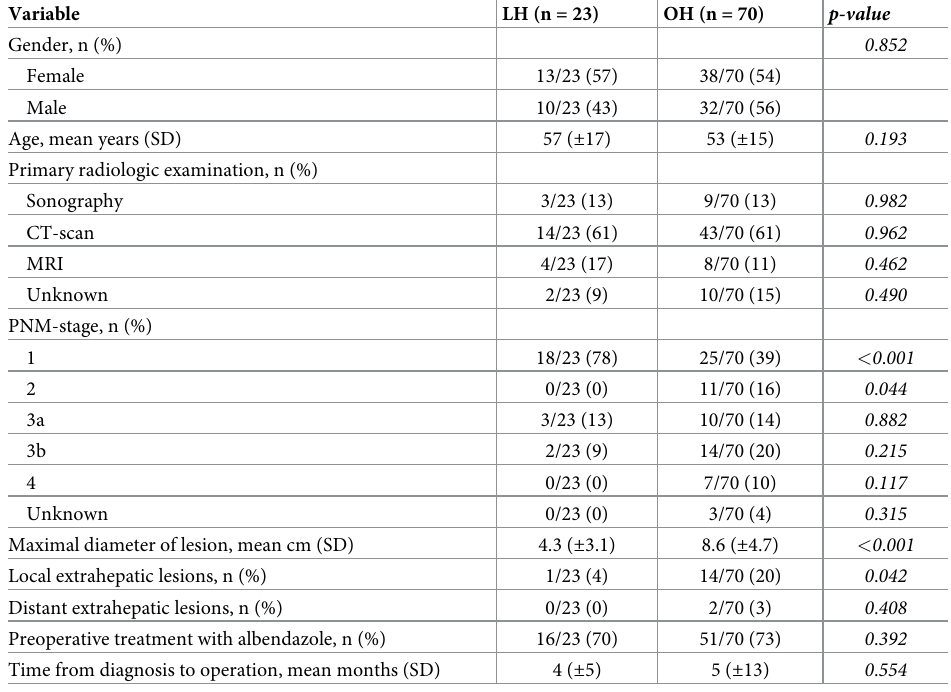
Table 1. Comparison of demographic and preoperative clinical data between laparoscopic and open resection of patients with hepatic alveolar echinococcosis. Variable LH (n = 23) OH (n = 70) p-value Gender, n (%) 0 . 852 Female 13/23 (57) 38/70 (54) Male 10/23 (43) 32/70 (56) Age, mean years (SD) 57 ( ± 17) 53 ( ± 15) 0 . 193 Primary radiologic examination, n (%) Sonography 3/23 (13) 9/70 (13) 0 . 982 CT-scan 14/23 (61) 43/70 (61) 0 . 962 MRI 4/23 (17) 8/70 (11) 0 . 462 Unknown 2/23 (9) 10/70 (15) 0 . 490 PNM-stage, n (%) 1 18/23 (78) 25/70 (39) < 0 . 001 2 0/23 (0) 11/70 (16) 0 . 044 3a 3/23 (13) 10/70 (14) 0 . 882 3b 2/23 (9) 14/70 (20) 0 . 215 4 0/23 (0) 7/70 (10) 0 . 117 Unknown 0/23 (0) 3/70 (4) 0 . 315 Maximal diameter of lesion, mean cm (SD) 4.3 ( ± 3.1) 8.6 ( ± 4.7) < 0 . 001 Local extrahepatic lesions, n (%) 1/23 (4) 14/70 (20) 0 . 042 Distant extrahepatic lesions, n (%) 0/23 (0) 2/70 (3) 0 . 408 Preoperative treatment with albendazole, n (%) 16/23 (70) 51/70 (73) 0 . 392 Time from diagnosis to operation, mean months (SD) 4 ( ± 5) 5 ( ± 13) 0 . 554 CT, computed tomography; LH, Laparoscopic hepatectomy; MRI, magnetic resonance imaging; OH, open hepatectomy; PNM, PNM system (P = parasitic mass in the liver, N = involvement of neighbouring organs, and M = metastasis); SD, standard deviation differences in terms of gender, age and diagnostic tools, the majority patients of the LH cohort were PNM stage 1 (n = 18/23, 78%) in contrast to only 39% (n = 25/70) in the OH cohort ( p = 0 . 002 ). The hepatic lesions in the LH cohort were located in one left-sided segment (n = 4/23, 17%), one central segment (n = 1/23, 4%), one right sided segment (n = 2/23, 9%), two left-sided segments (n = 2/23, 9%), two central segments (n = 2/23, 9%), two right-sided segments (n = 2/23, 9%), more than three right-sided segments (n = 3/23, 13%) and more than three bilateral segments (n = 7/23, 30%). In contrast, hepatic lesions of the OH cohort were located in one left-sided segment (n = 1/70, 1%), one central segment (n = 3/70, 4%), one right sided segment (n = 6/70, 9%), two left-sided segments (n = 5/70, 7%), two central segments (n = 2/70, 3%), two right-sided segments (n = 12/70, 17%), two bilateral segments (n = 2/70, 3%), more than three left-sided segments (n = 7/70, 10%), more than three central segments (n = 4/70, 6%), more than three right-sided segments (n = 13/70, 19%) and more than three bilateral segments (n = 15/70, 21%). The mean maximal diameter was significantly higher (8.6 cm vs. 4.3 cm, p < 0 . 001 ) in the OH cohort. Local extrahepatic lesions were more common in OH cohort (OH 20% [n = 14/70] vs. LH 4% [n = 1/23], p = 0 . 042 ) and consisted of infiltration to the diaphragm and the greater omentum. A distant extrahepatic disease to brain (n = 1) and peritoneum (n = 1) existed in two patients of the OH cohort (n = 2/70, 3%), compared to absent extrahepatic disease in the LH cohort ( p = 0 . 408 ). The interdisciplinary tumor board has recommended a resection of that brain metastasis due to neurological symptoms after pri- mary hepatectomy. The other patient received a tumor debulking surgery in palliative inten- tion because he suffered from severe edemas of the lower limbs and massive ascites due to an